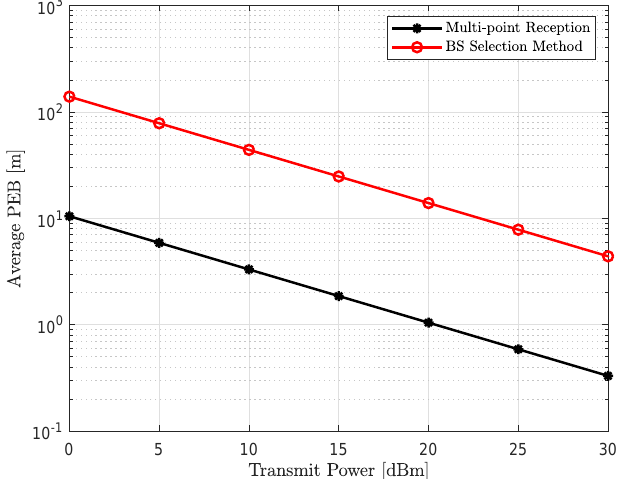
Figure 4. Average positioning accuracy as a function of increasing uplink transmit power P t with the link blocking probability P b =